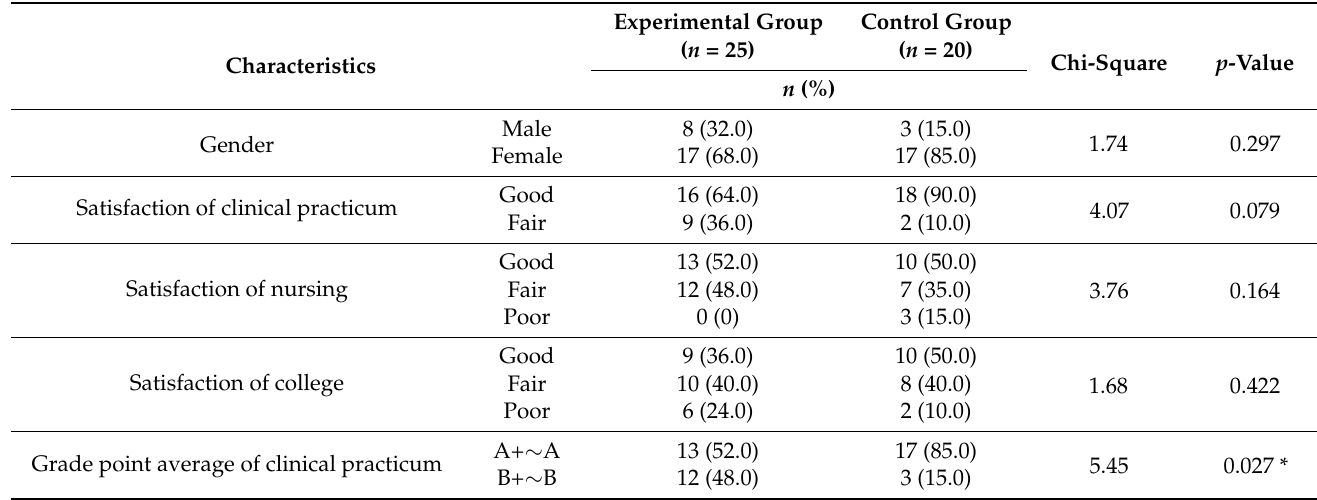
Table 2. Homogeneity in general characteristics of subjects between experimental and control groups ( n = 45).